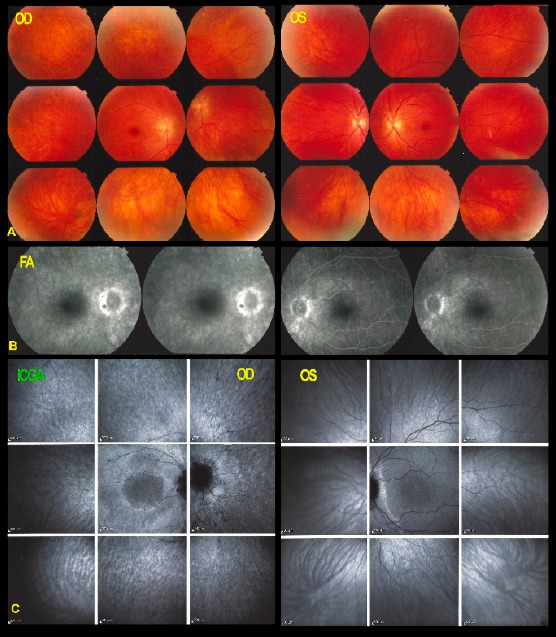
Figure 1. Fundus photographs, FA & ICGA frames ODS in AZOOR patient 1 at presentation. ( A ) No manifest changes are visible on the fundus photographs ODS. ( B ) FA shows discreet late hyperfluorescence in the posterior pole around the fovea OD and around the inferior part of the optic disc OS and along the superior temporal vascular arcade OS. ( C ) ICGA ODS (late angiographic frames) does not show capillary drop-out .